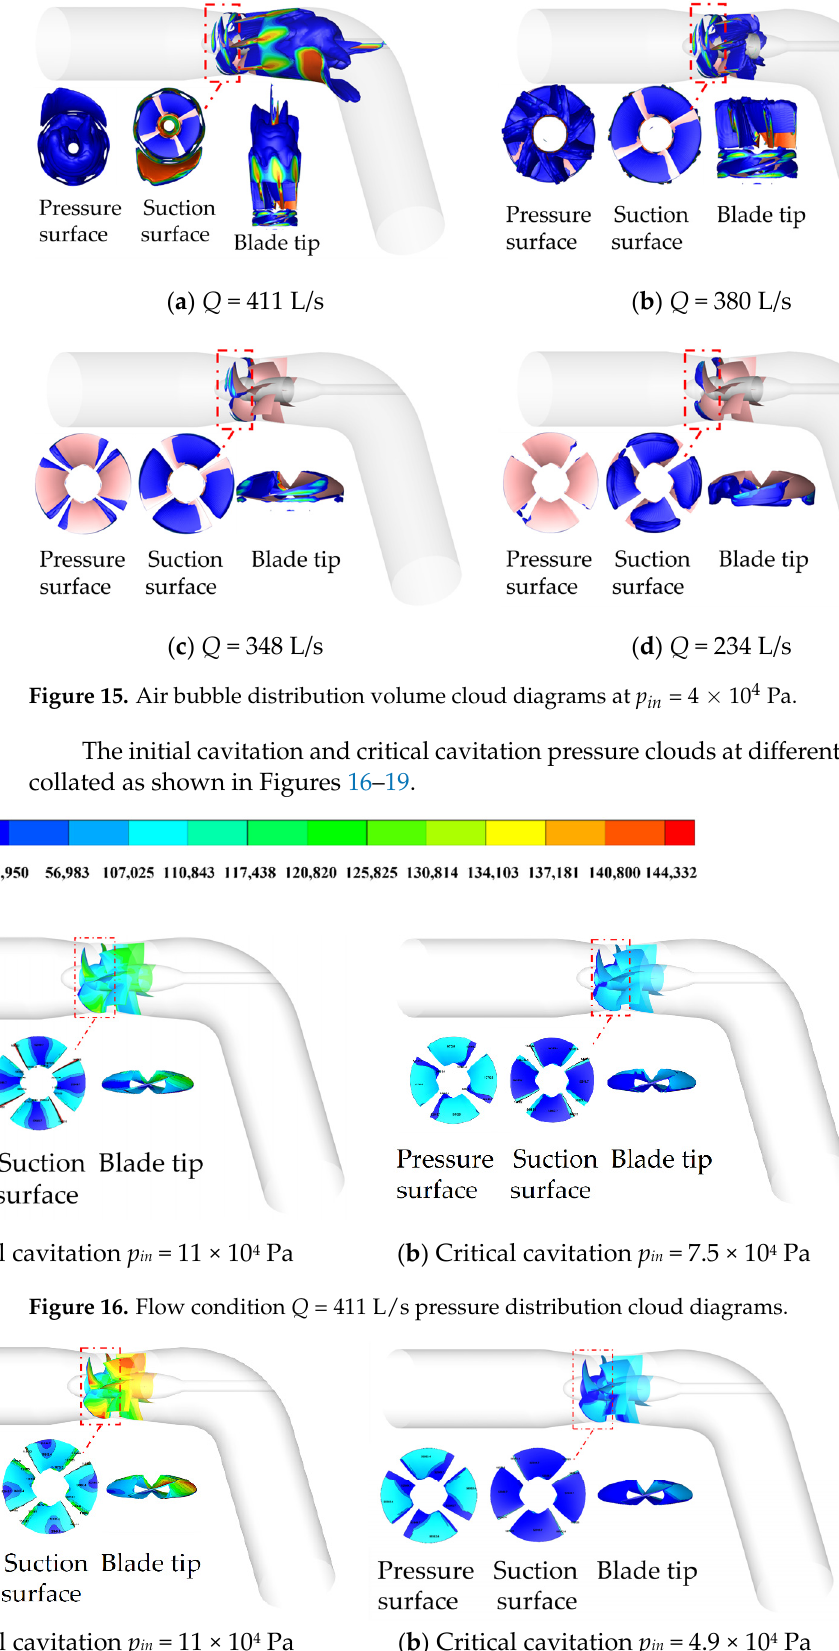
Figure 16. Flow condition Q = 411 L/s pressure distribution cloud diagrams.